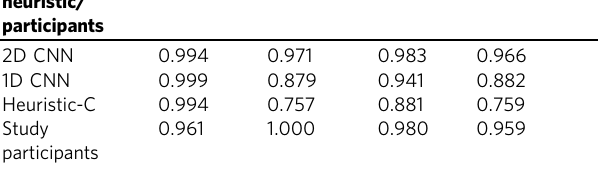
CNN Convolutional Neural Network.